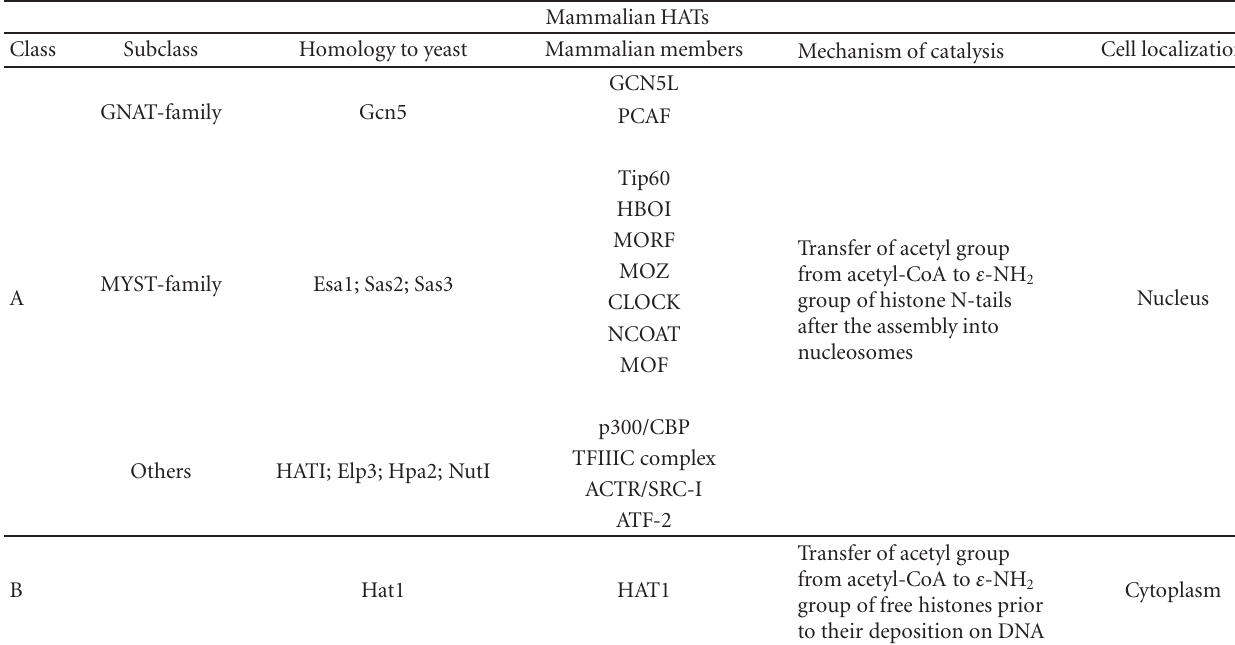
Table 1: Mammalian Members of HAT